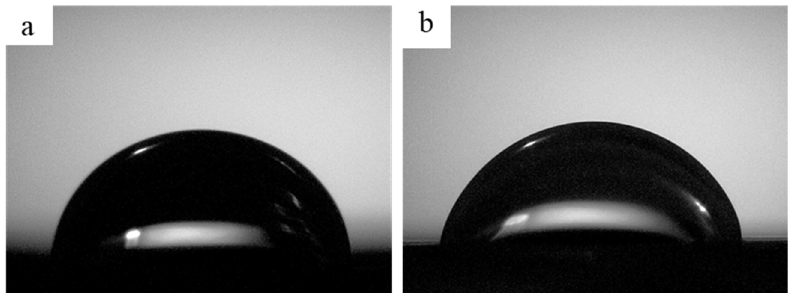
Figure 10. The representative of contact angle images (3 s) of the water droplet on: ( a ) PCL scaffold, ( b ) PCL/AgNPs scaffold.